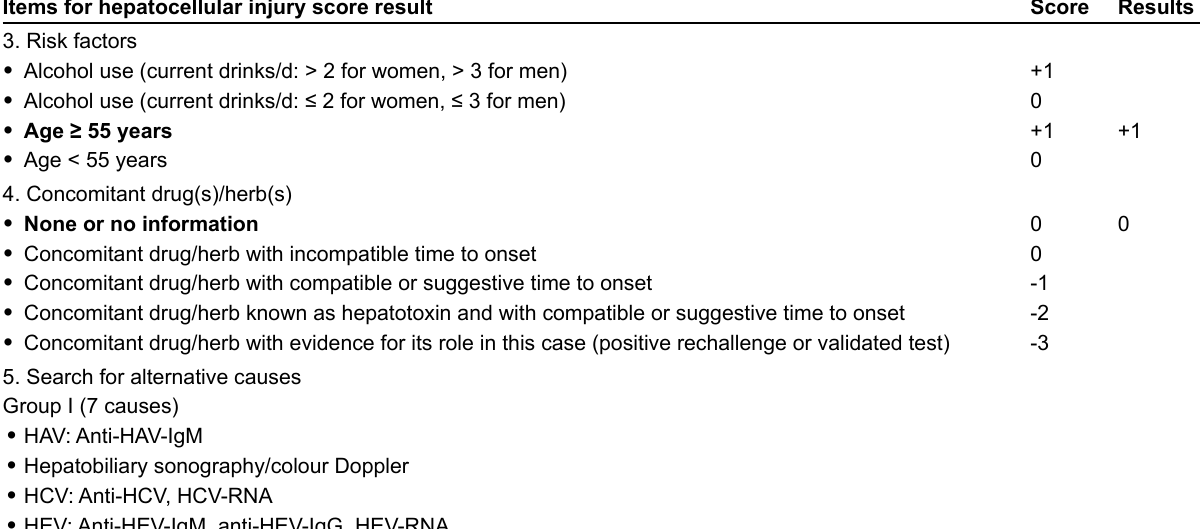
Table 1. Score results of the present case according to the updated RUCAM for hepatocellular injury* ( continued ) Items for hepatocellular injury score result Score